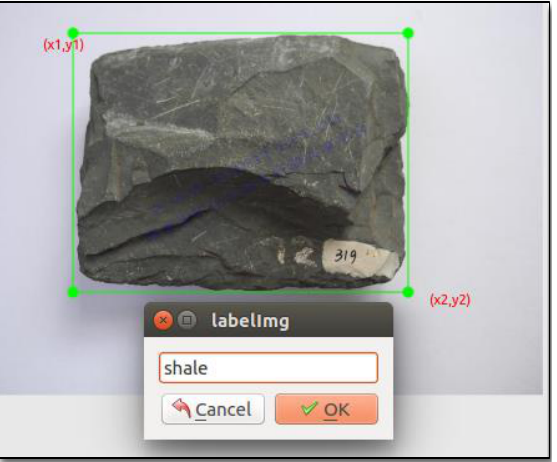
Figure 9. Labeled ground-truth(GT) information, including object position(x 1 ,y 1 ),(x 2 ,y 2 ) and rock